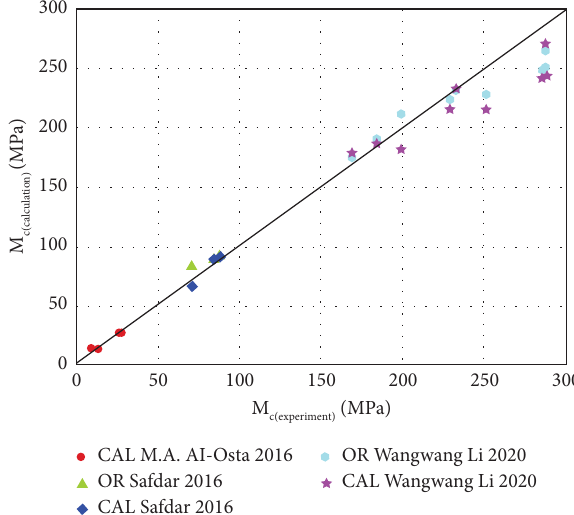
Figure 11: Te ratios of the analytical results to the experimental results.